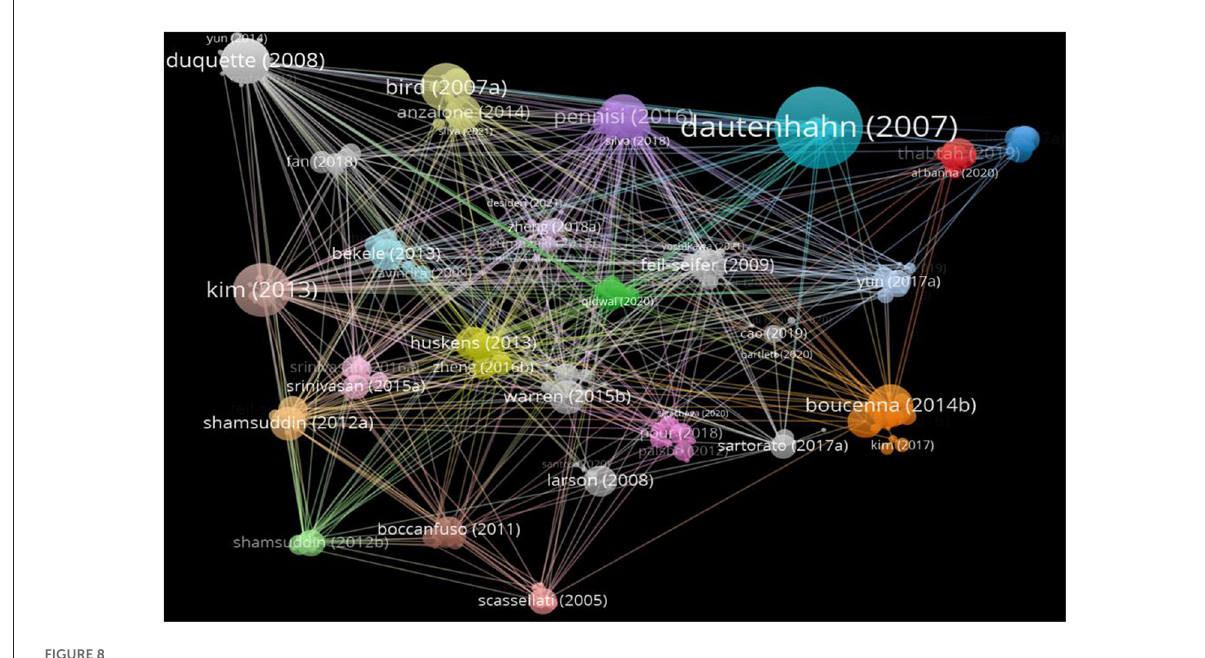
FIGURE8 The network of co-cited references related to Al on ASD.